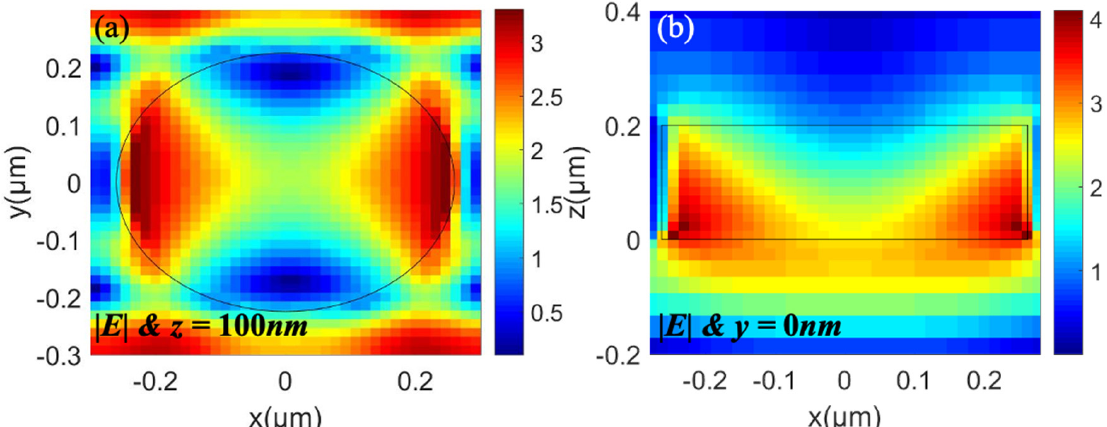
Figure 3. Electric field distributions of the reflection peak marked in Figure 2b: ( a ) Normalized electric field distribution on the x - y plane with z = 100 nm; ( b ) Normalized electric field distribution on the x - z plane with y = 0.